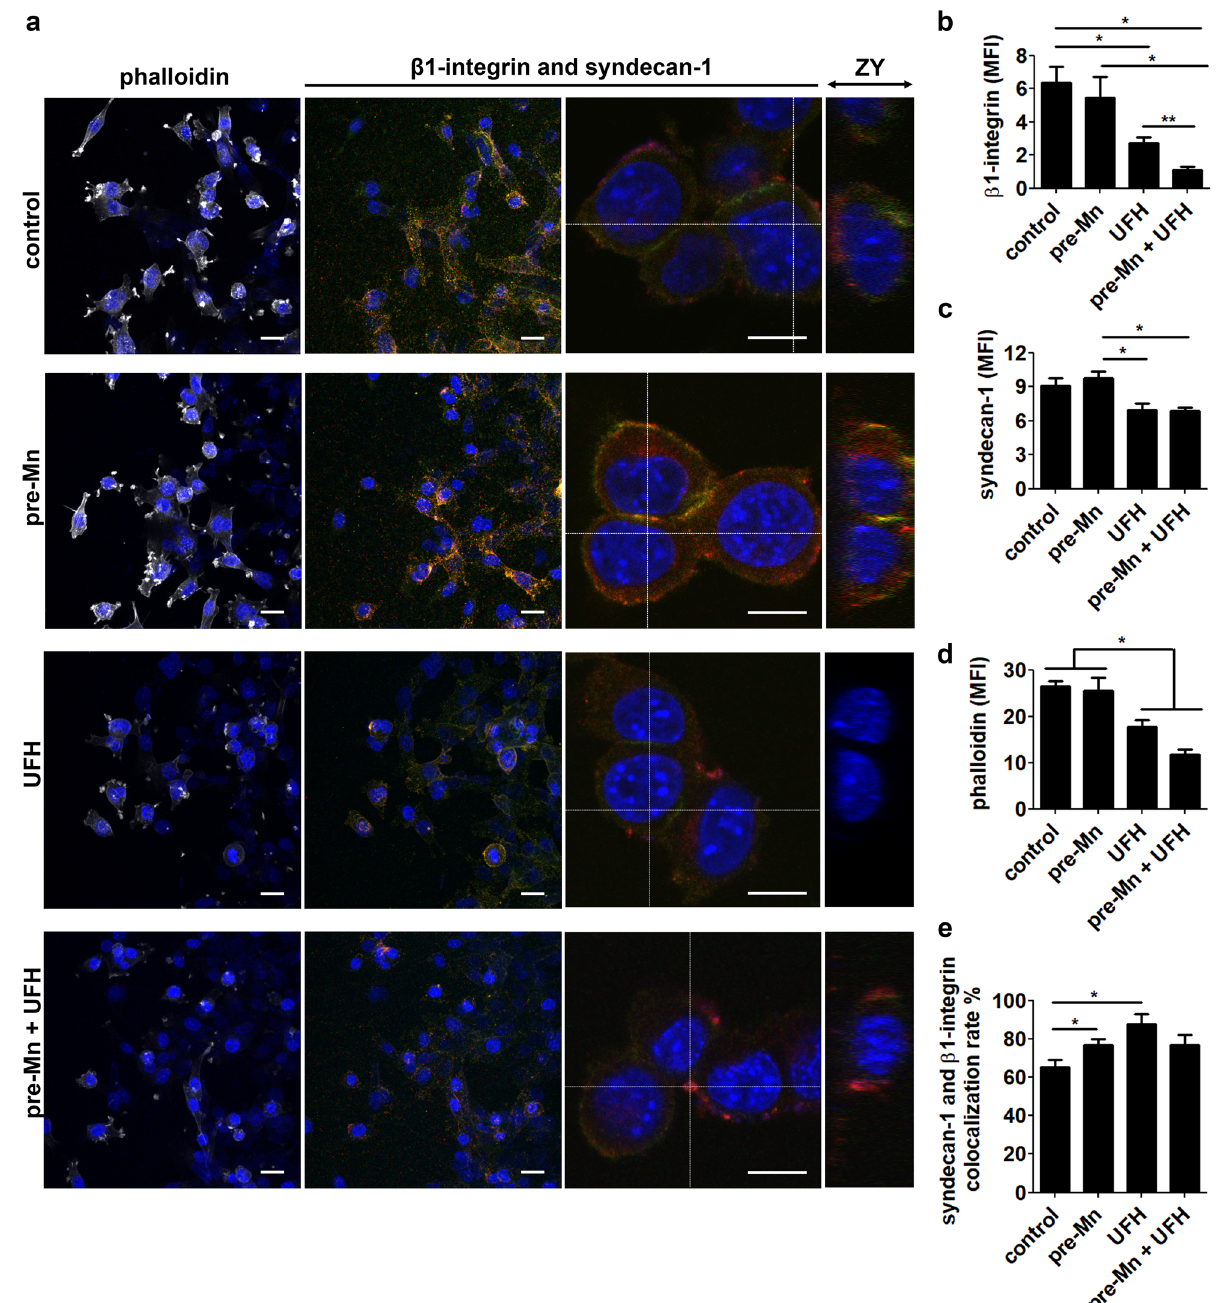
Figure 7. Manganese affects β1-integrin and syndecan-1 expression in tumor cells. Confocal microscopy images of ( a ) immunostainings for β1-integrin, syndecan-1 and F-actin (phalloidin). DAPI (blue), β1-integrin (red), syndecan-1 (green) and phalloidin (white). ZY axis projections were generated from higher magnification images of β1-integrin and syndecan-1 merged stainings. Scale bars are 25 µm (lower magnification) and 10 µm (higher magnification). N = 6. Images were quantified regarding fluorescence intensity for ( b ) β1-integrin, ( c ) syndecan-1 and ( d ) phalloidin-Alexa 488. (e) β1-integrin and syndecan-1 colocalization rates. MFI, mean fluorescence intensity. One-way ANOVA with Bonferroni’s post test. *p < 0.05; **p <